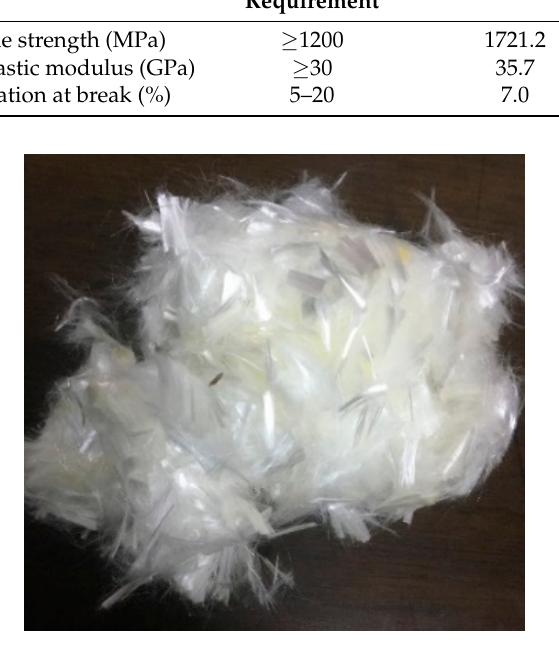
Figure 1. Image of PVA.